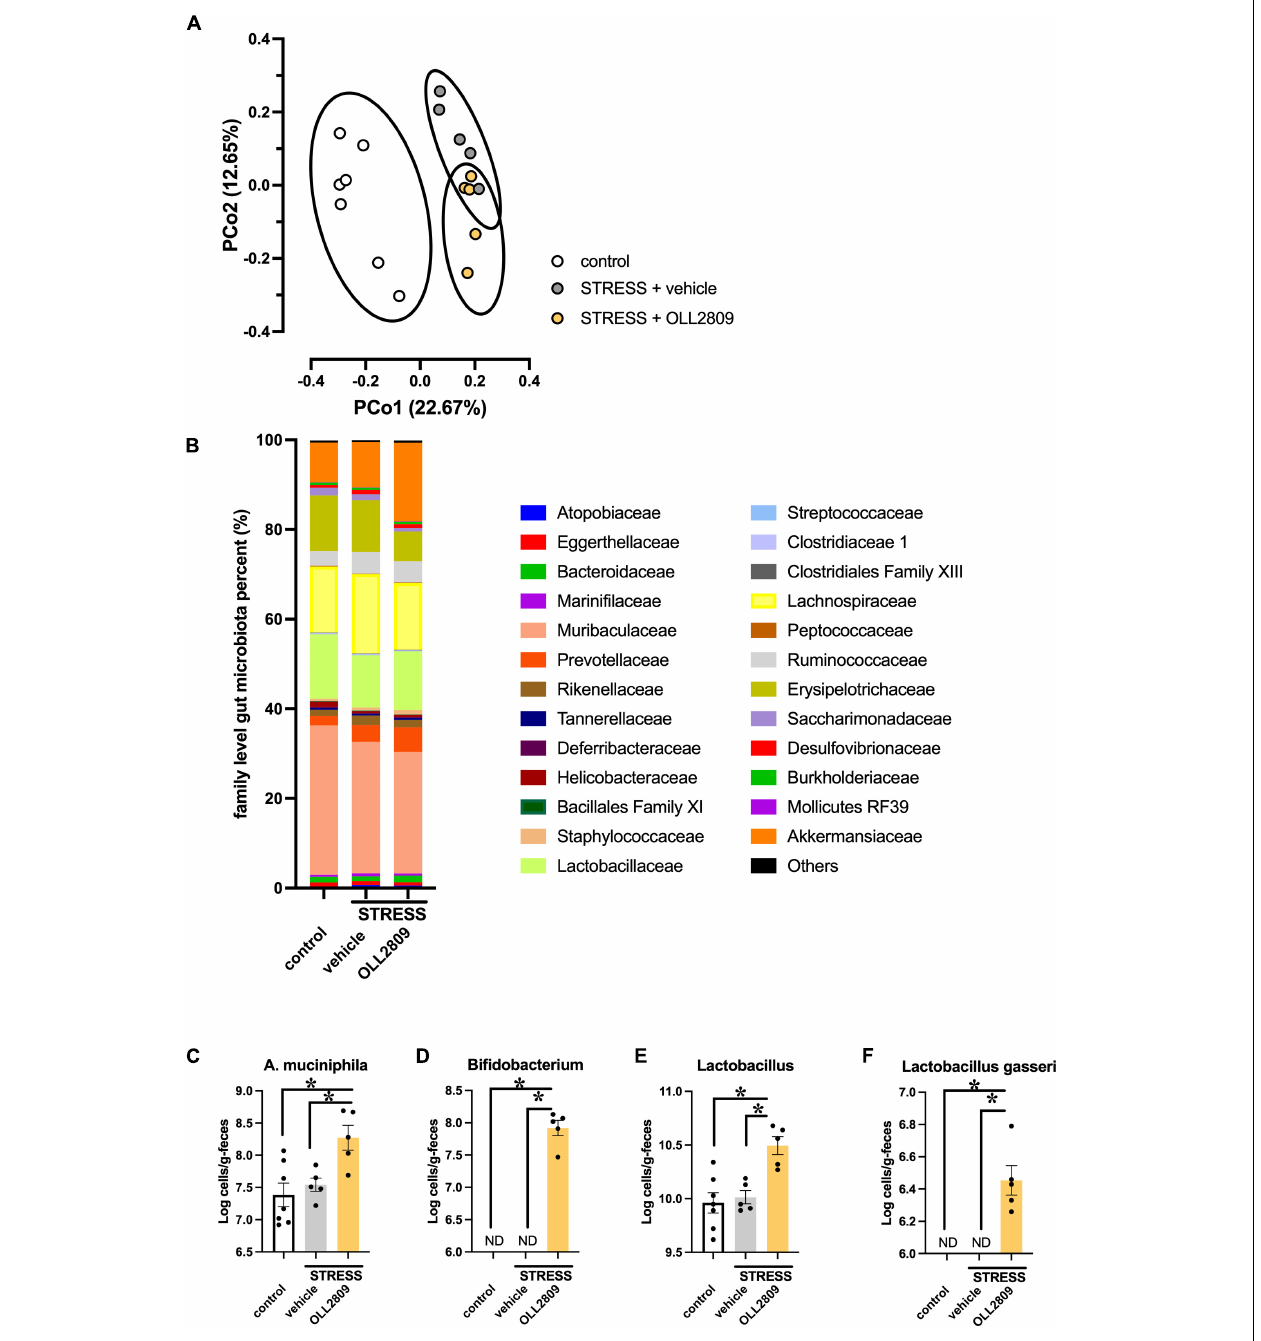
FIGURE 3 | The 16S rRNA amplicon sequence analysis reveals changes in mouse gut microbial diversity and the relative abundance of microorganisms. (A) The PCoA analysis plots of Jaccard-based diversity. Each circle represents 95% confidence interval of the group. (B) Relative abundance of gut microorganisms at the family level. (C) Quantitative real-time PCR analysis of Akkermansia muciniphila , (D) Bifidobacterium , (E) Lactobacillus , and (F) Lactobacillus gasseri . Each bar indicates the mean ± S.E.M. * p < 0.05, PERMANOVA, Tukey–Kramer test or Dunn’s test. Each plot represents the number of mice. ND: not detected (detection limit, 6.0 log cells/g feces). Control, n = 7; stress + vehicle, n = 5; stress + OLL2809, n = 5.